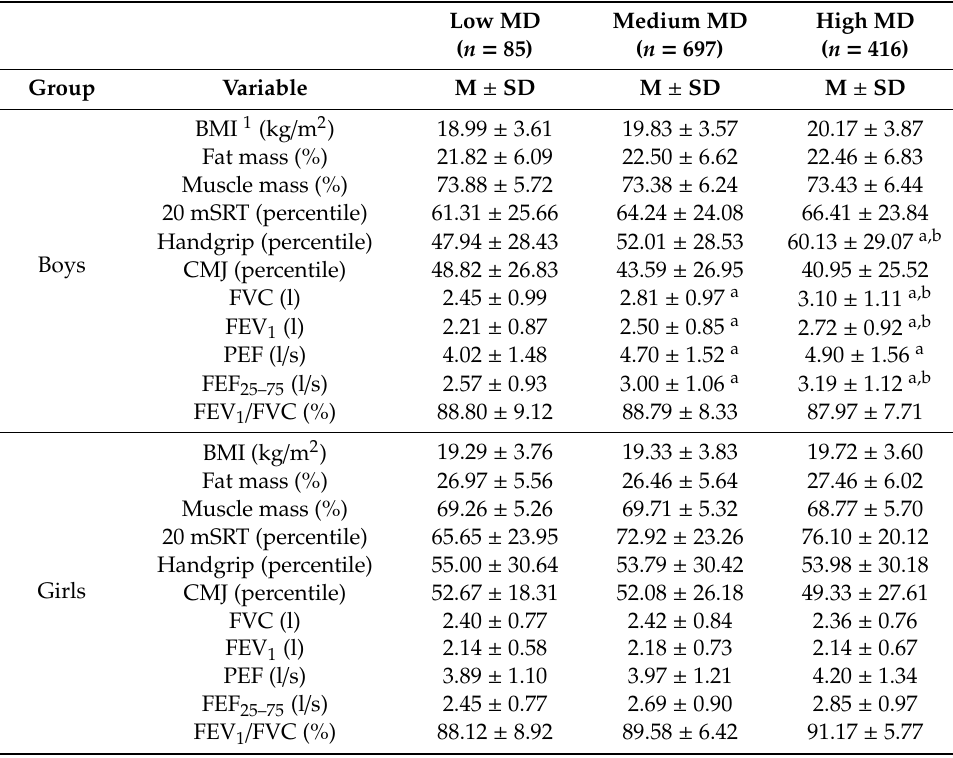
Figure 1. Differences between pubertal status. * Differences between prepubertal and pubertal groups, p < 0.05 Figure 1. Di ff erences between pubertal status. * Di ff erences between prepubertal and pubertal groups, p < 0.05 Table 1. Di ff erences between groups adherence to the Mediterranean diet